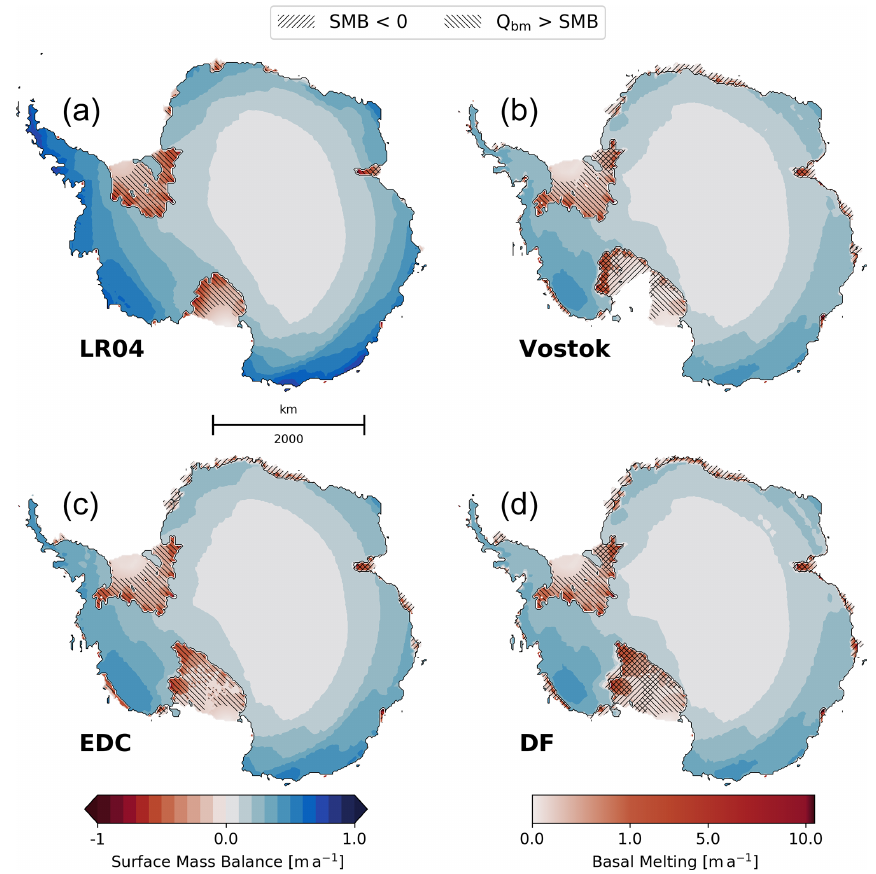
Figure 8. Surface mass balance (SMB, ma − 1 ) for the grounded ice and basal melting ( Q bm , ma − 1 ) for the ice shelves for the CFEN simulations at 415ka. Hatched areas show where basal melting dominates over surface mass balance and where surface mass balance is negative (i.e. where surface ablation